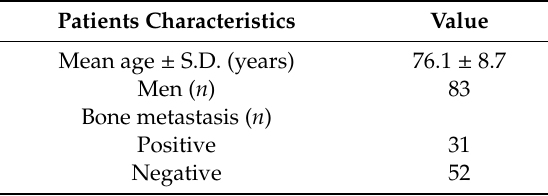
Table 2. Patient characteristics.